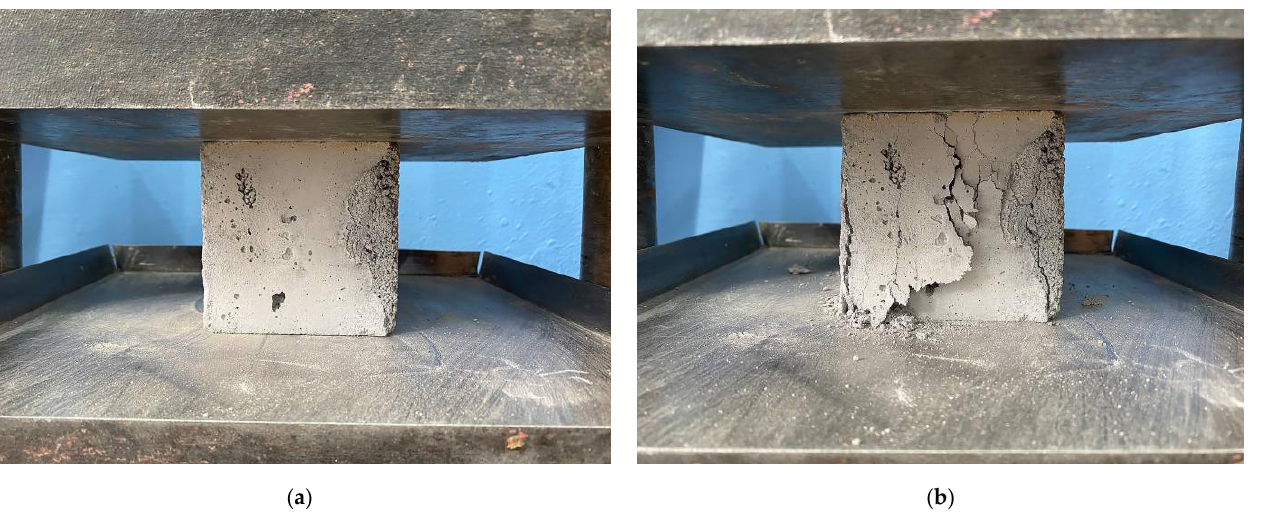
Figure 12. Photographs of the collapsed concrete specimen containing 6% MSP: ( a ) Initial phase; ( b ) Collapse phase.